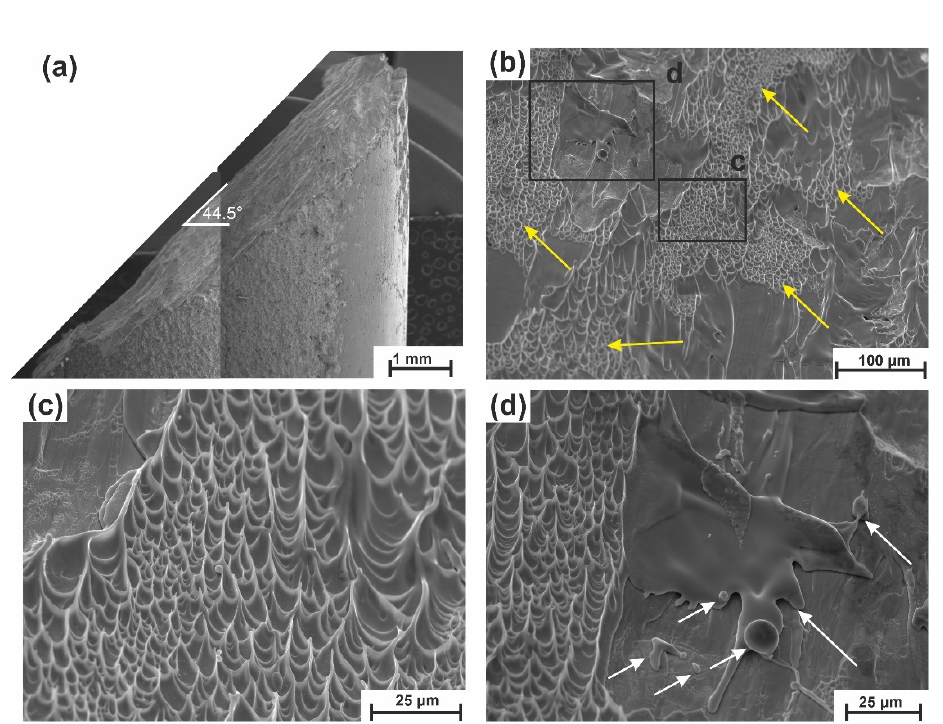
Figure 44. ( a ) AMZ4 compression test specimen fabricated via LPBF, after failure, ( b ) vein-like patterns on the fracture surface indicated by yellow arrows, ( c ) higher magnification image of vein-like patterns, and ( d ) presence of liquid-like features indicated by white arrows [32].